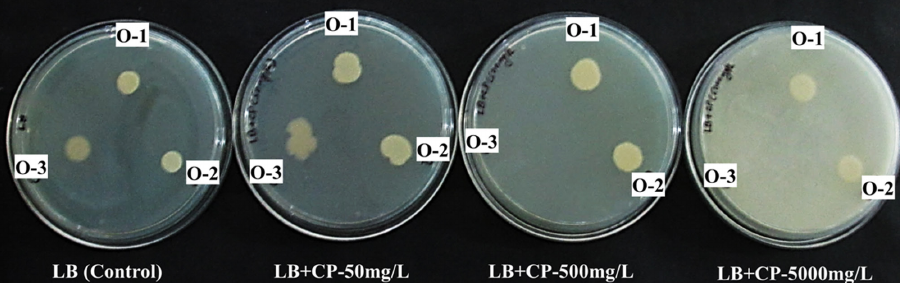
Fig. 1. Growth of O-1, O-2 and O-3 on LB agar media supplemented with different concentration of CP along with controll without